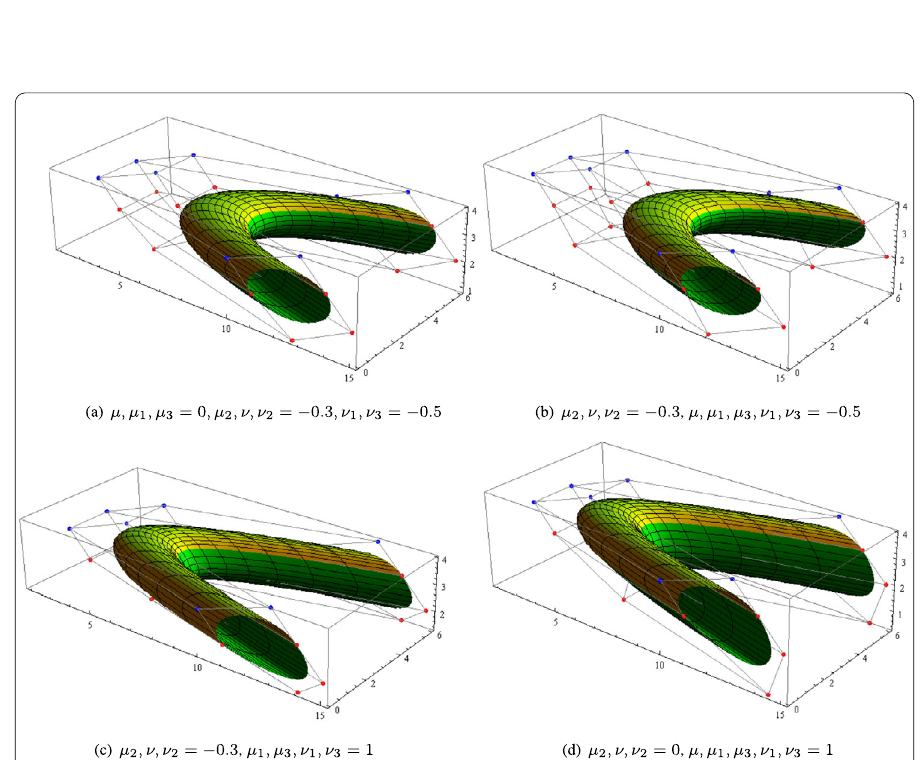
Figure 20 C 2 continuous GBT-Bézier swept surfaces with different shape